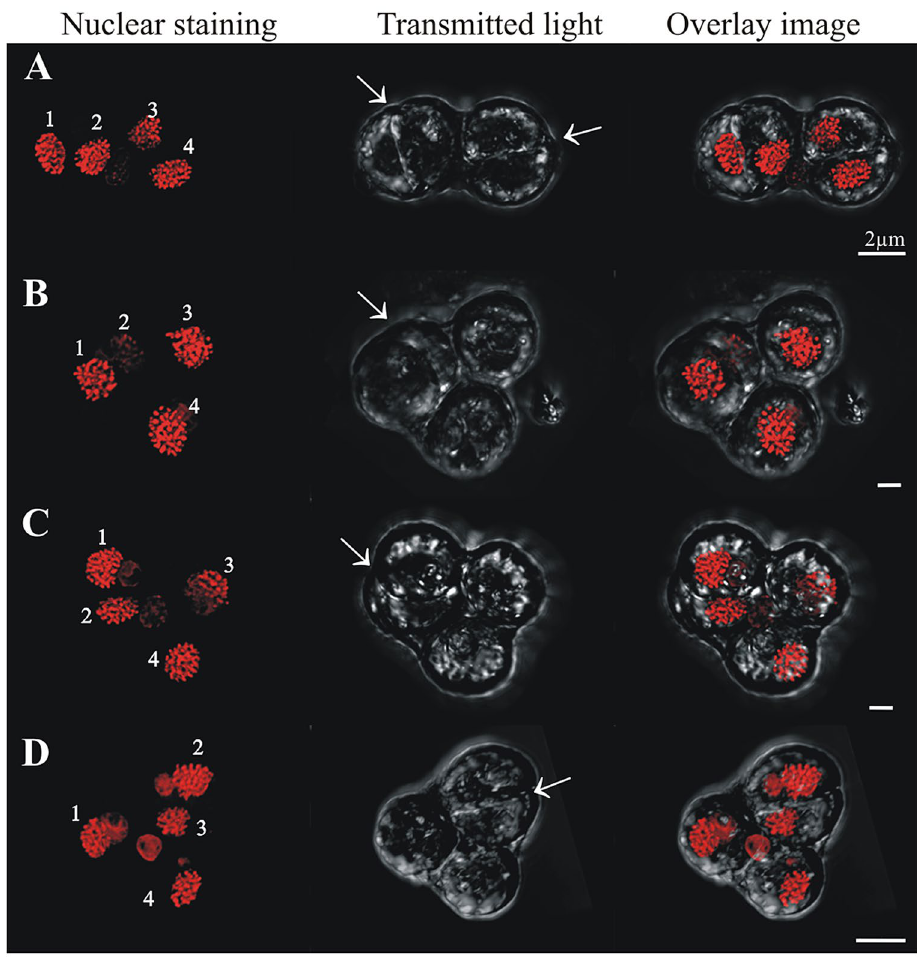
Figure 9. Confocal images of cells sorted in the (> 2C–4C) DNA content gate that have four nuclei and different numbers of lobes in their external morphology (lobes clearly visible in the transmitted light). ( A ) two lobes with a middle furrow of division each (arrows), ( B – D ) three lobes with a middle furrow of division in the biggest lobe